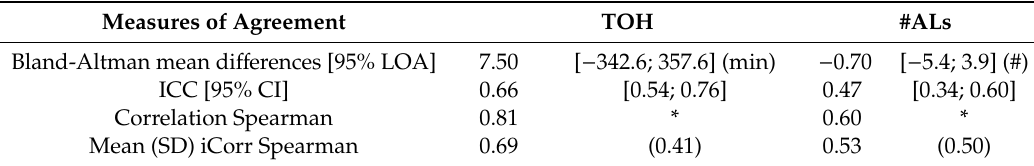
Figure 11. Bland Altman for multiple observations per participant [72] for TOH (n = 140 days) ( a ) and #ALs (n = 170 days) ( b ). Table 5. Measures of agreement for daily TOH and #ALs.